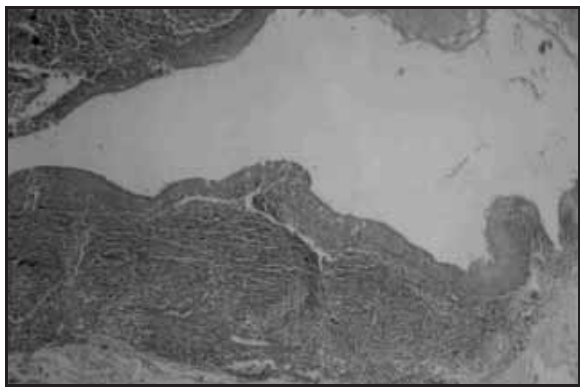
Figura 3 – Fotomicrografia demonstrando cavidade revestida por epitélio pavimen- toso estratificado, ora paraceratinizado ora não ceratinizado, com infiltrado linfocítico circunscrevendo parcialmente o revestimento epitelial (HE, 40 × ) HE: hematoxilina e